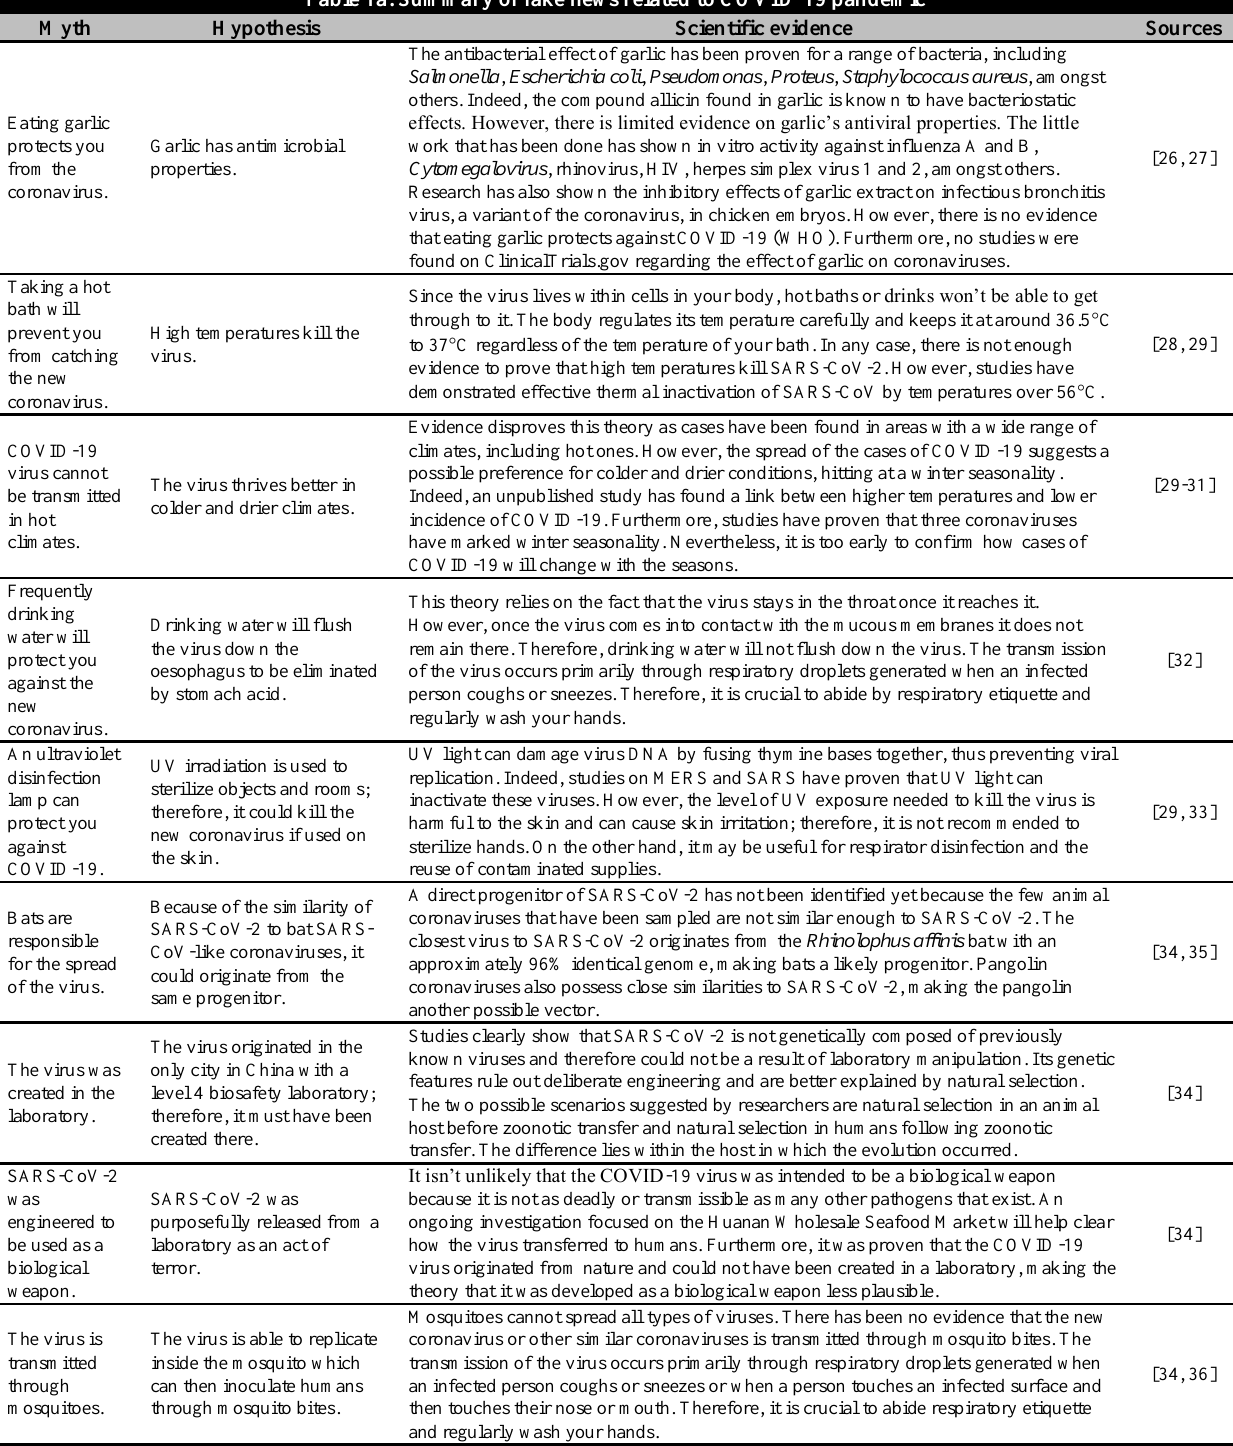
Table 1a. Summary of fake news related to COVID-19